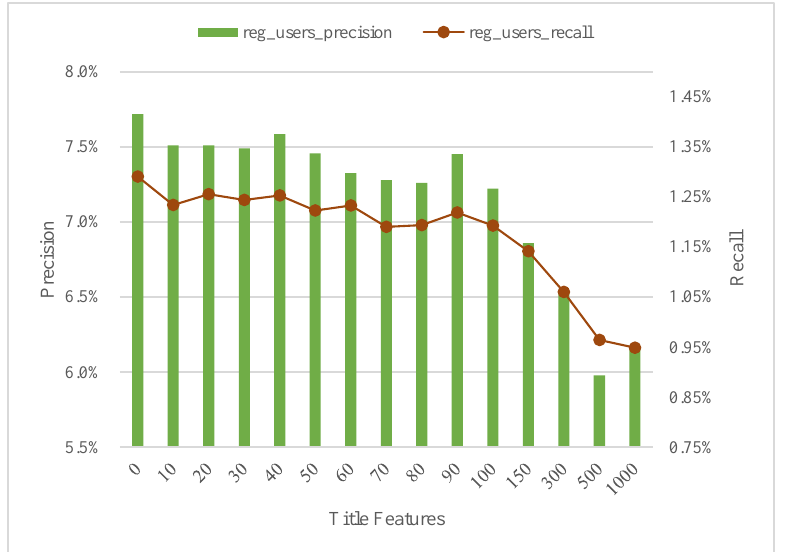
Figure 2. Precision and recall results for the regular users set with different amount of title